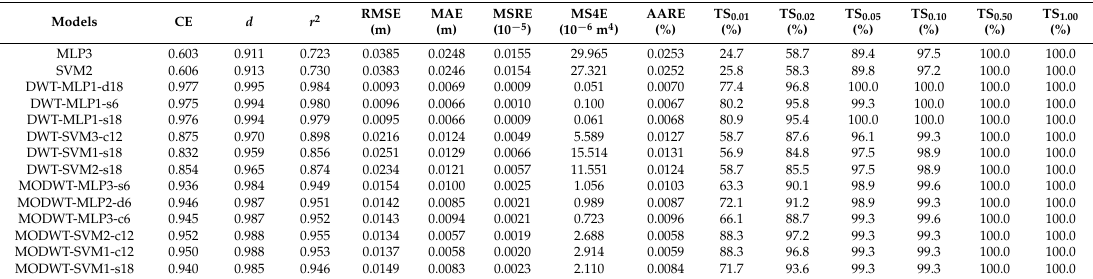
Table 4. Comparison of higher performance models for the medium